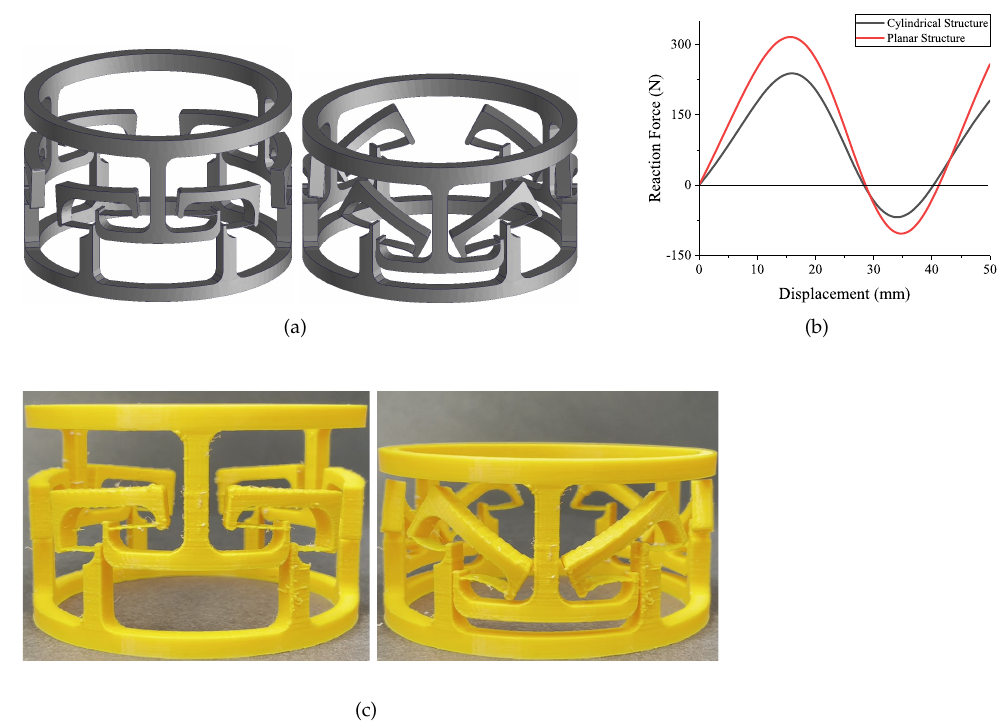
Figure 11. The cylindrical deployable structure: ( a ) the design; ( b ) the FEA simulation result; ( c ) two stable configurations of the cylindrical